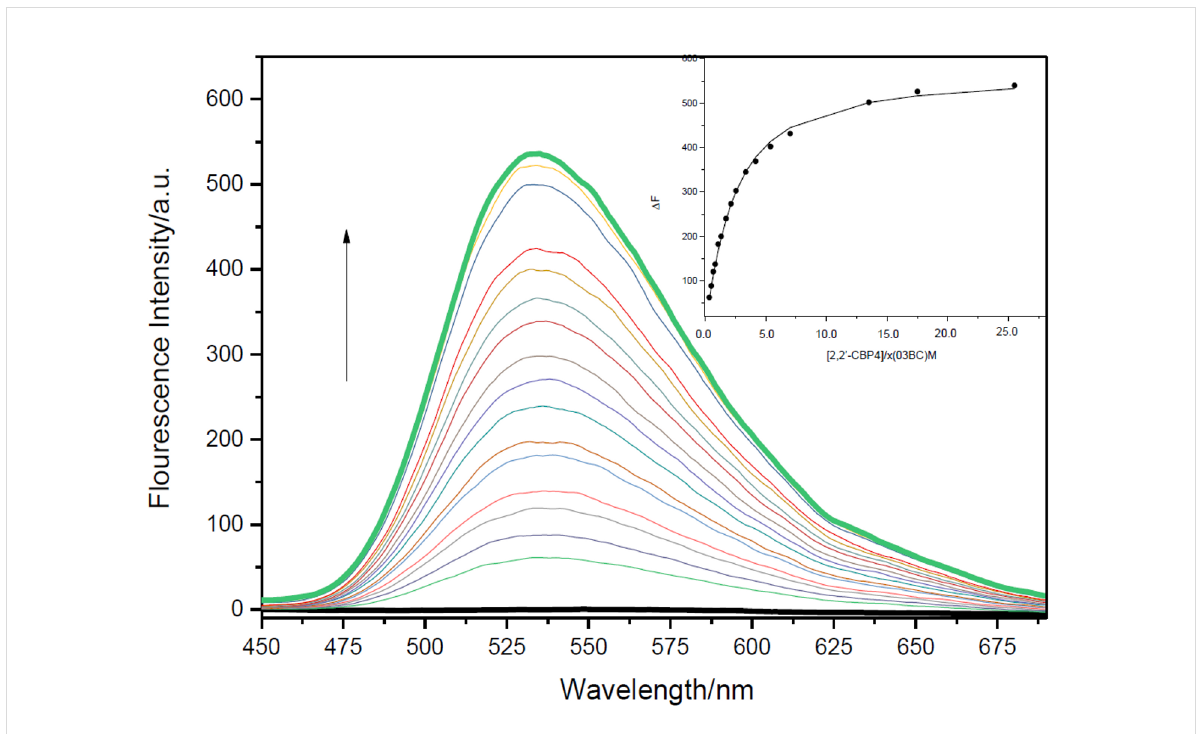
Figure 2: Fluorescence spectra of P in the absence and presence of 2,2’-CBP4 in aqueous phosphate buffer solution at pH 7.4 at 298 K. The excita- tion wavelength is at 352.0 nm. Inset: the nonlinear least-squares analysis to calculate the association constant using the fluorescence emission at 530 nm.